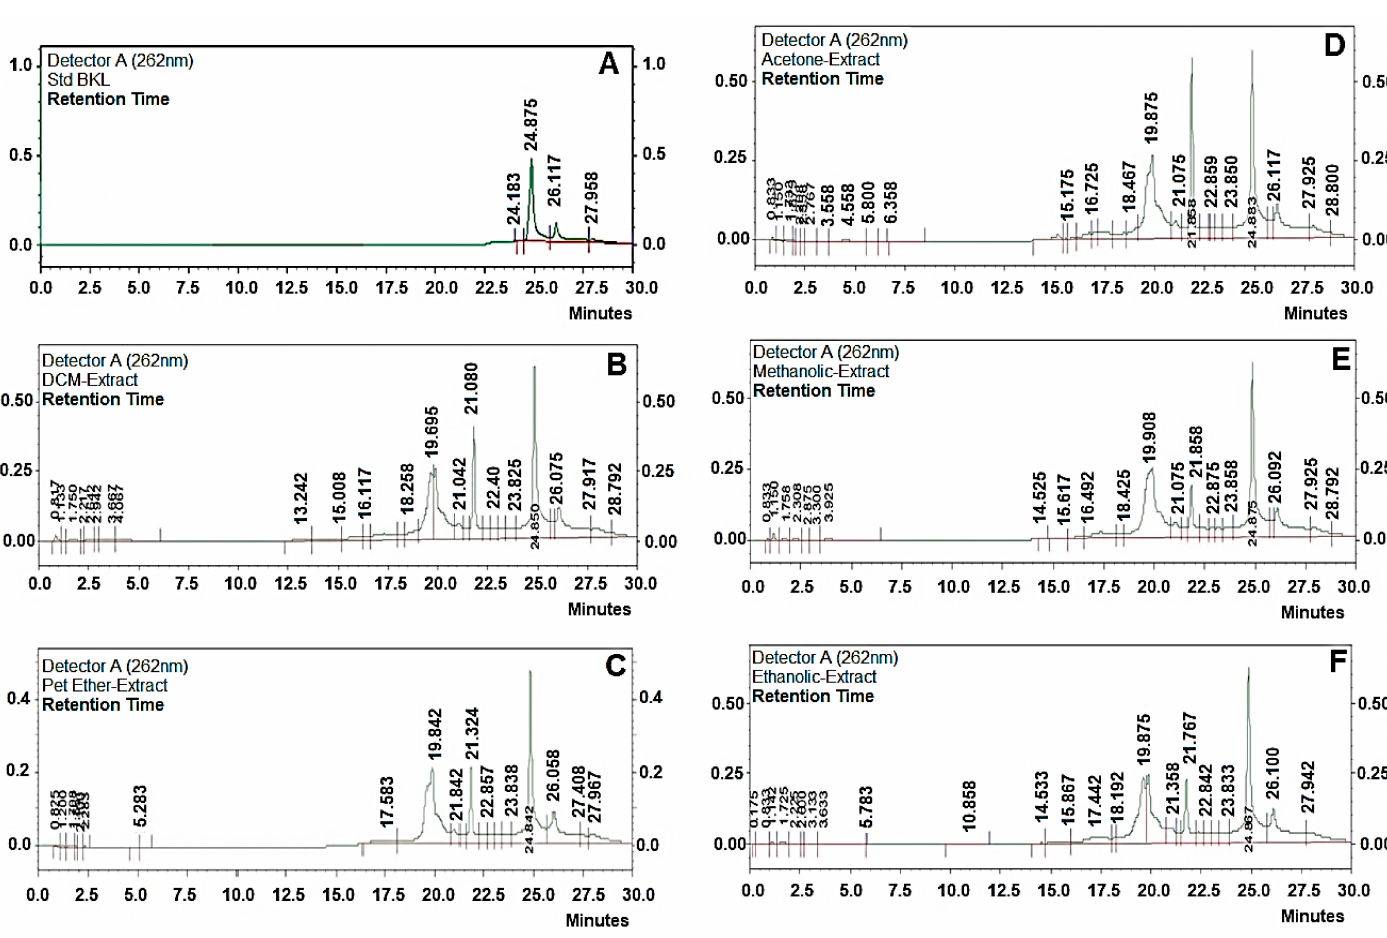
Figure 2. High-performance liquid chromatography HPLC chromatograms of bakuchiol (BKL) ( A ) standard BKL, ( B ) DCM extract, ( C ) petroleum ether, ( D ) acetone ( E ) methanolic, and ( F ) ethanolic extract.